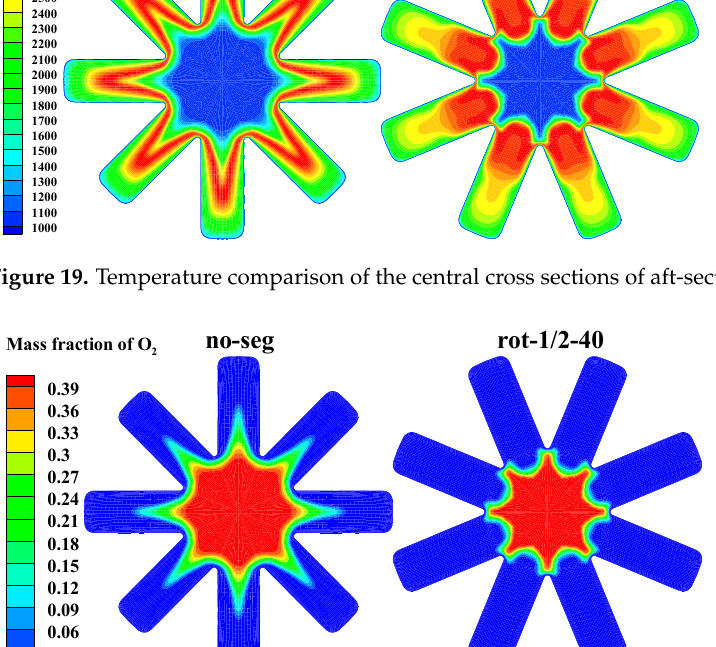
Figure 20. Mass fraction of O 2 comparison of the central cross sections of aft-section grain port.